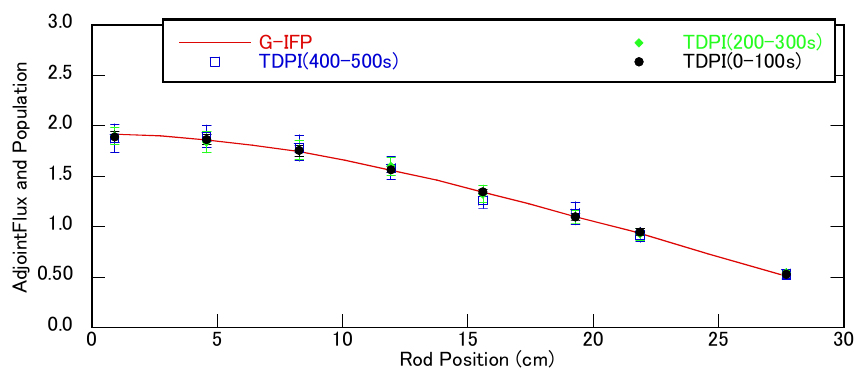
Figure 6. Comparison of adjoint flux by G-IFP to total neutron importance by